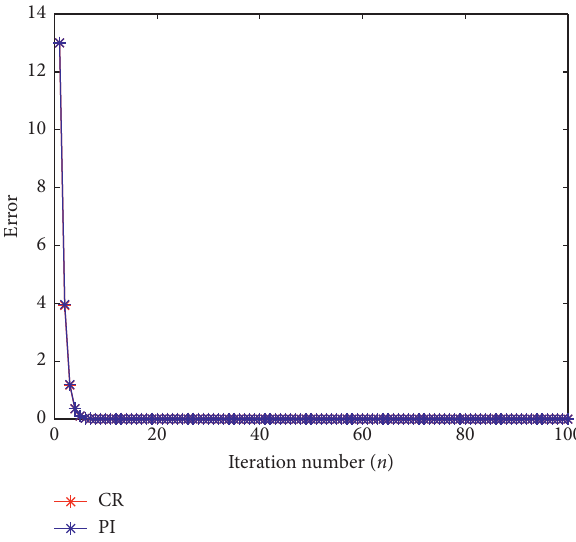
Figure 3: Errors versus iteration numbers ( n ): Example